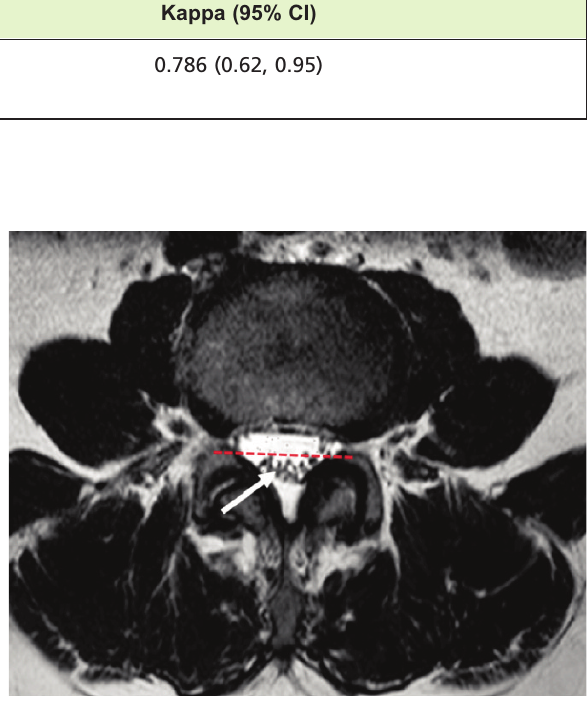
MRI T2 image of a patient with negative nerve root Fig. 2: sedimentation sign. A negative sign was when the majority of the lumbar nerve root (arrow) was located in the dorsal half (dotted line) of the dural